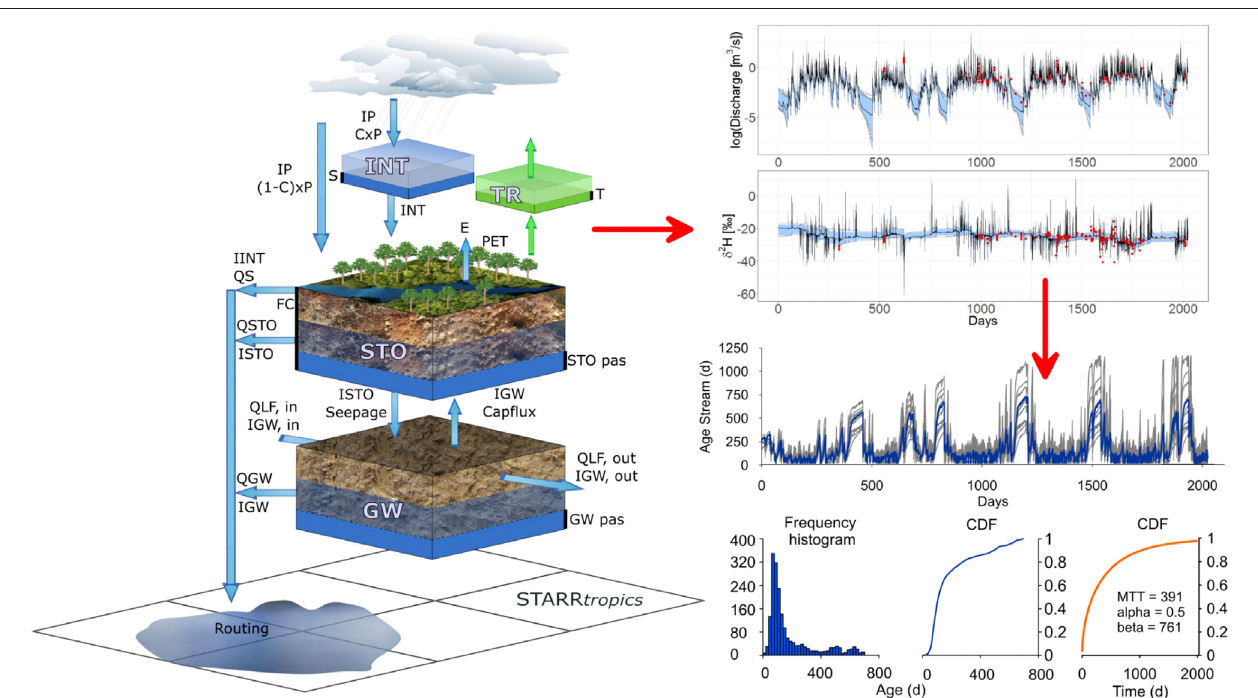
FIGURE14| Modelconceptualizationandsimulations.TheleftpanelshowstheschematicmodelstructureoftheSpatially-distributedTracer-AidedRainfall-Runoff model (STARR) adapted to tropical rainforest catchments (Dehaspe et al., 2018) and further modi fi ed to include an eco-hydrological water partitioning. The coupled model simulates stream fl ow (observations in red and simulations in black and blue) and isotopes (here: δ 2 Hcomposition) ascatchment integrated outputs (upper right panels) .Thelowertwopanelsontherightexhibitstreamwaterageestimatesindaysasthemodelcanbeusedtotracktheageofwaterin fl uxesandstorages.The STARRtropics simulated cumulative distribution function (CDF) of stream water ages is compared to a best- fi t lumped convolution integral model using a Gamma distribution as transfer function. Both models result in comparable mean transit times (MTT) of around 1 year with a relatively similar form of the transit time distribution. Figure adapted using data from Dehaspe et al.